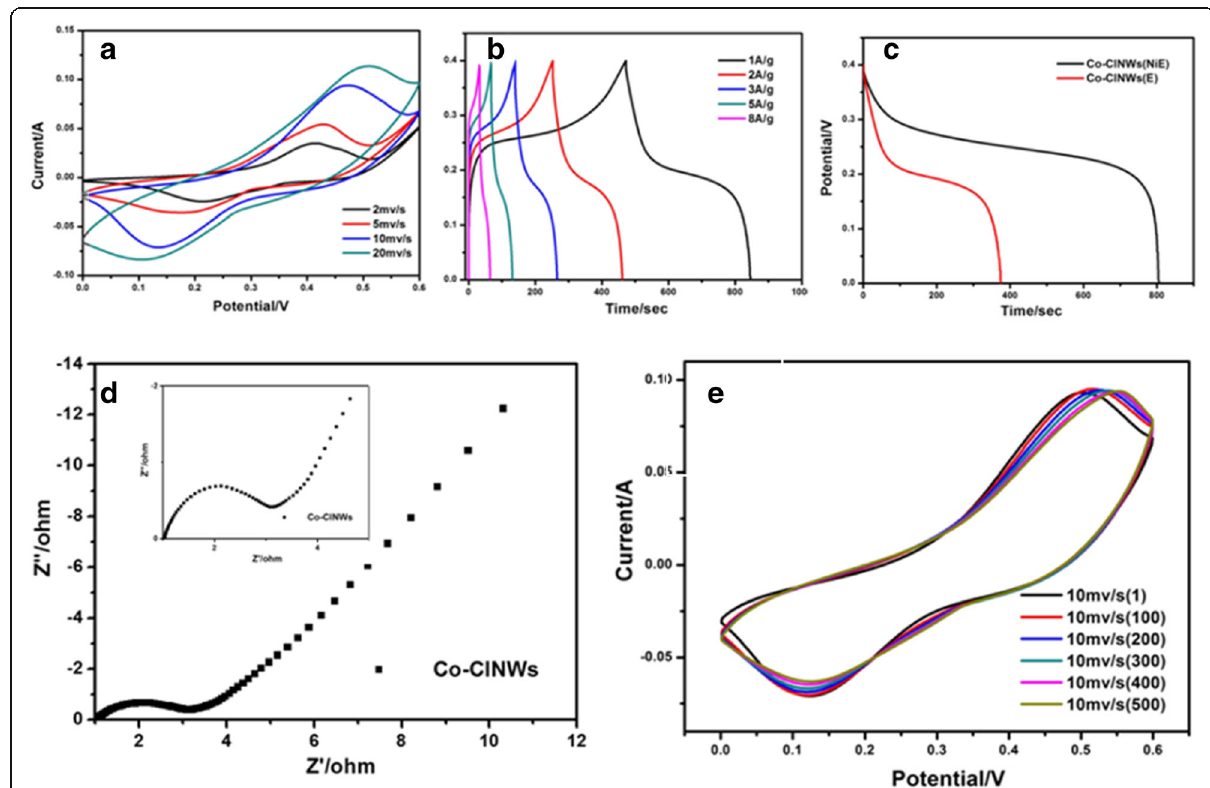
Fig. 5 a CV curves of Co-ClNWs(E) at various scan rates. b Galvanostatic charge and discharge curves of Co-ClNWs(NiE) at various current densities. c Comparison of discharge curves of two electrodes. d The electrochemical impedance spectra of Co-ClNWs(E). e Comparison of CV curves after 500 cycles of